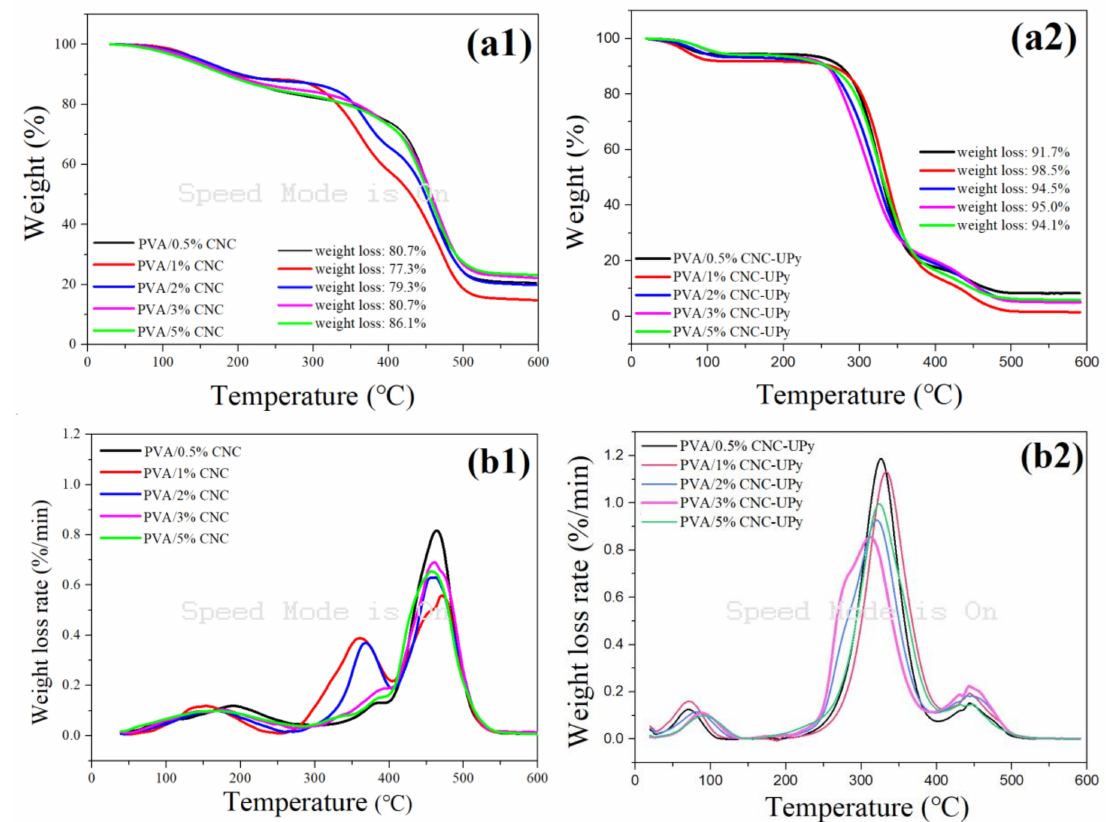
Figure 8. TGA ( a1,2 ) and DTG ( b1,2 ) curves of di ff erent PVA composite membranes.